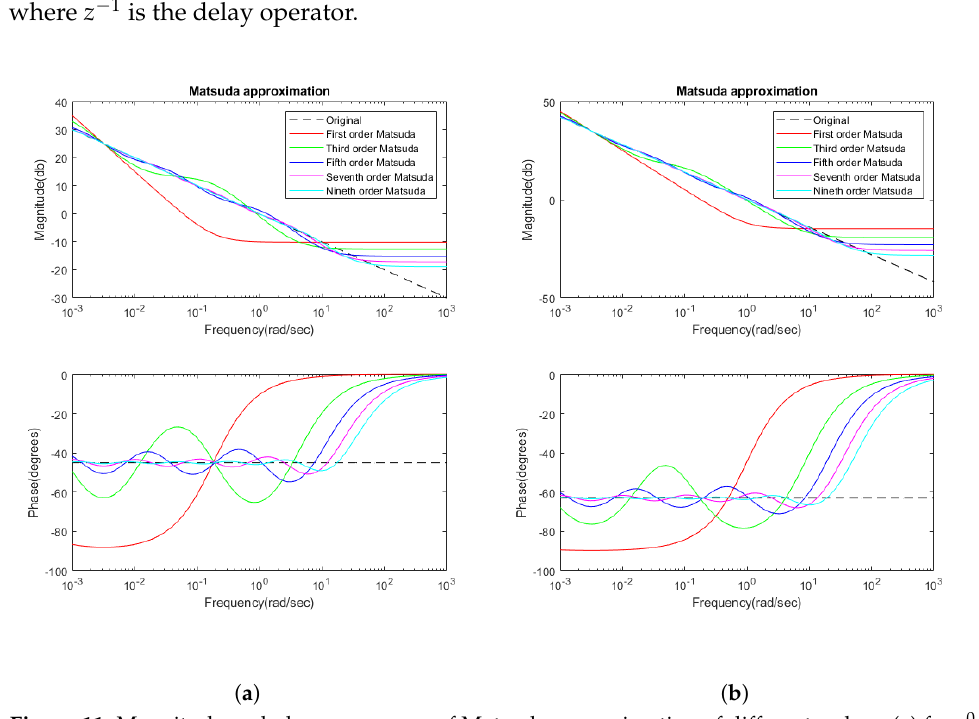
Figure 11. Magnitude and phase responses of Matsuda approximation of different orders: ( a ) for s 0.5 ; and ( b ) for s 0.7